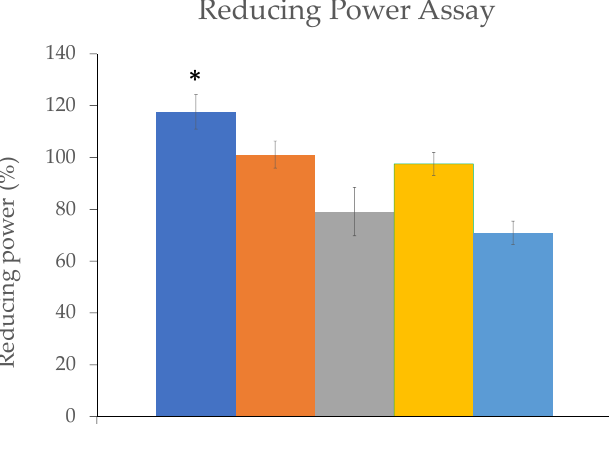
Figure 7. Reducing power assay for the QI gall extract before fractionation (crude extract) and after fractionation (F4), along with the synthetic gallotannin compound and chemo-drugs (Temozolomide and Tamoxifen) (* p < 0.05 for F4 vs. all other groups).